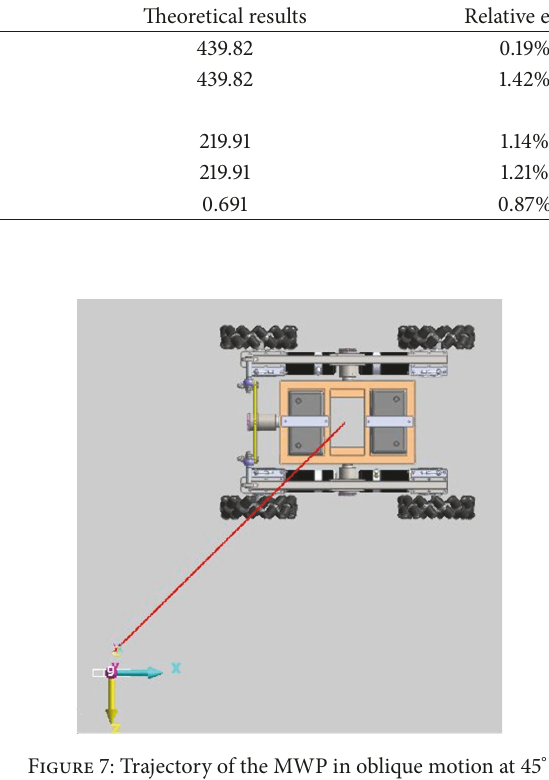
Figure 7: Trajectory of the MWP in oblique motion at 45 ∘